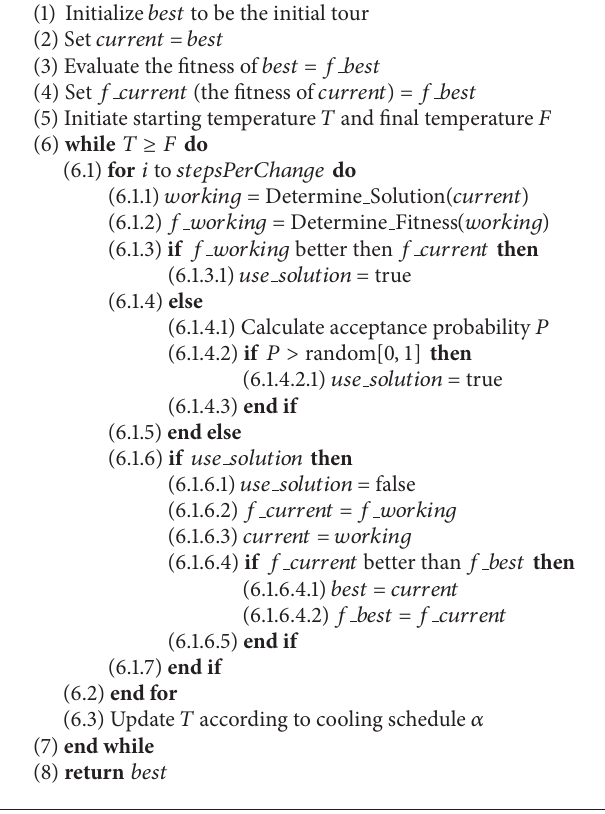
Algorithm 3: Simulated